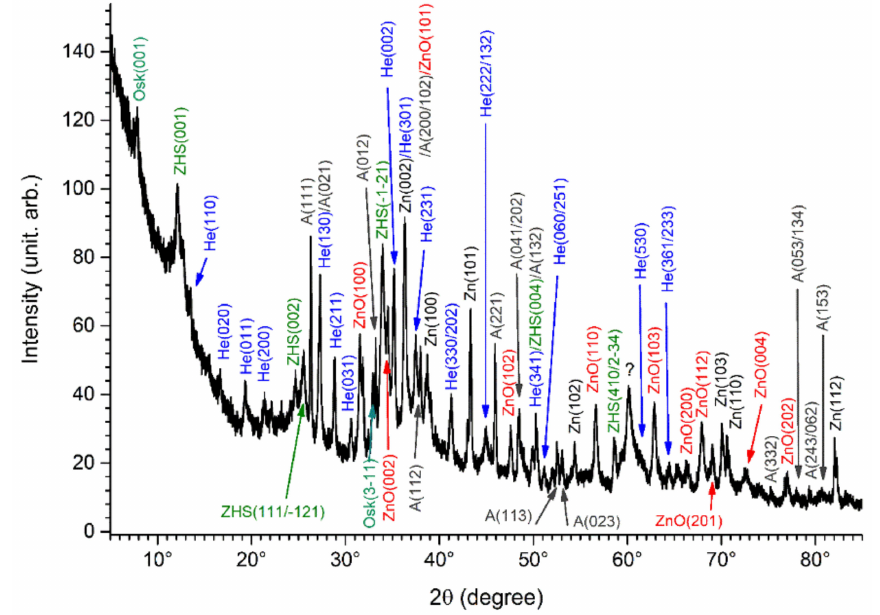
Figure 9. XRD analysis of the Zn-2-coated electrode surface after the 6-month galvanic corro- sion experiment. Osk(hkl) = osakaite, ZHS(hkl) = zinc hydroxysulfate, He(hkl) = hemimorphite, A(hkl) = aragonite, Zn(hkl) = zinc, and ZnO(hkl) = zincite, with the corresponding Miller